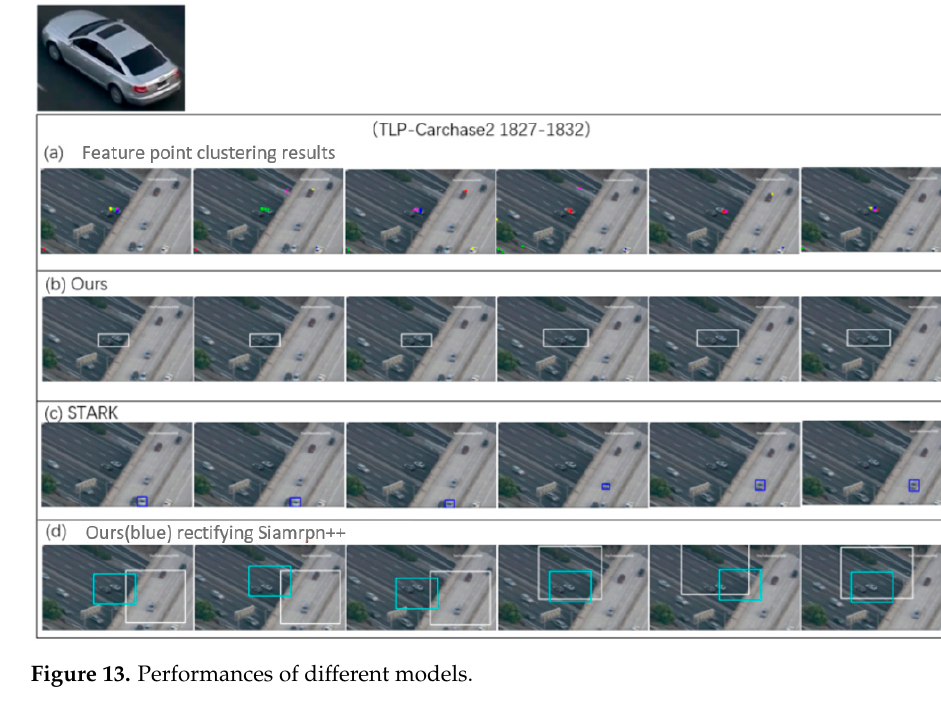
Figure 13. The internal parameter, K, was selected based on the results in Figure 14.